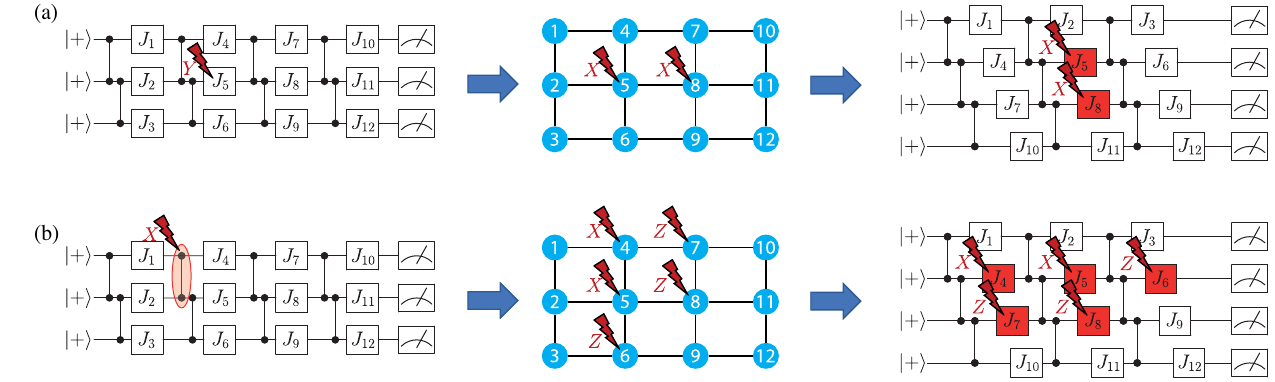
FIG. 10. Examples of the required error correlations between the two MBQC-derived circuits for the protocol to fail. The left circuit corresponds to a horizontal flow in a 3 × 4 lattice cluster, where either a (a) single-qubit or a (b) two-qubit error occurs. The effect of either error in the underlying MBQC pattern is shown in the middle. Translating to the circuit picture for a vertical flow, the right circuit then shows the error that would be required on the other device (correlated with the first) for the two circuits to still produce consistent